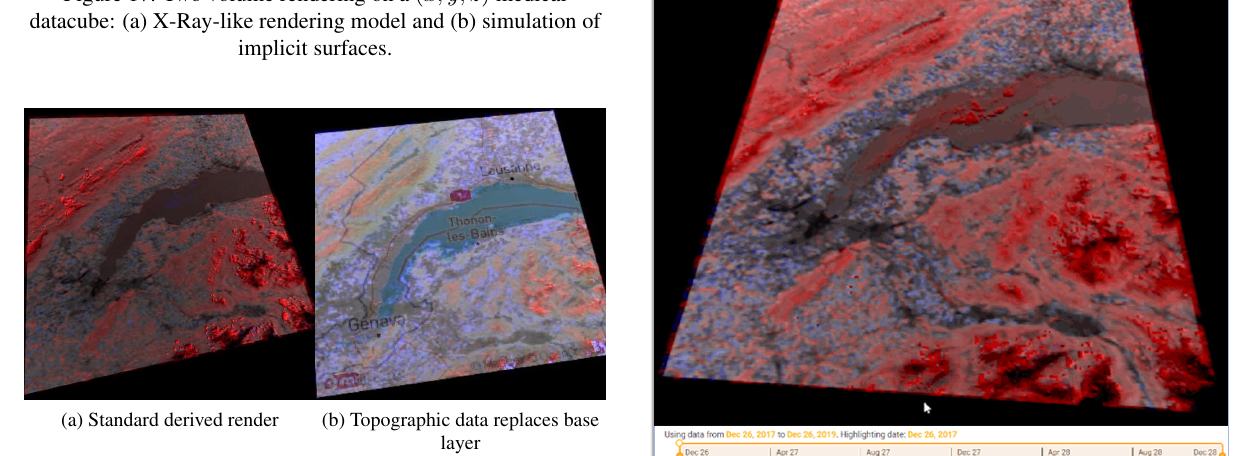
Figure 18. Derived rendering illustration: red/blue areas show positive/negative differences with the selected base layer. In (b) the gray base layer is replaced by a topographic map.